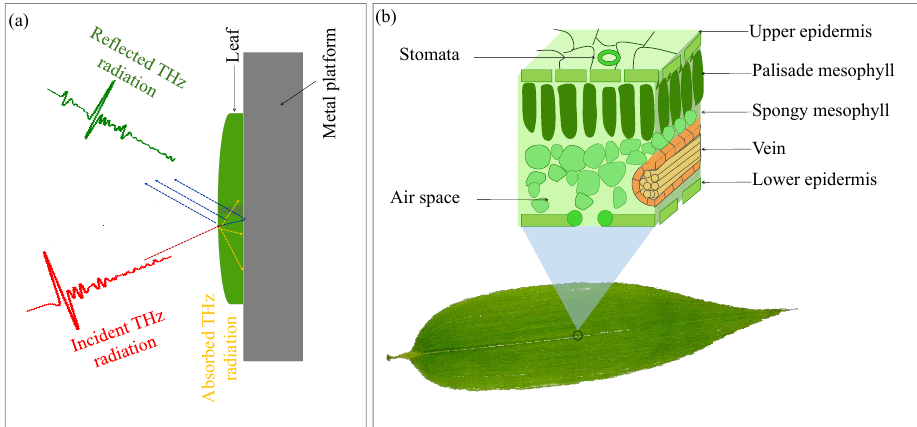
Figure 2. ( a ) Schematic showing interaction of THz radiation with the leaf sample (mounted on a metal platform) in reflection configuration and ( b ) the internal structure of a typical leaf and its main